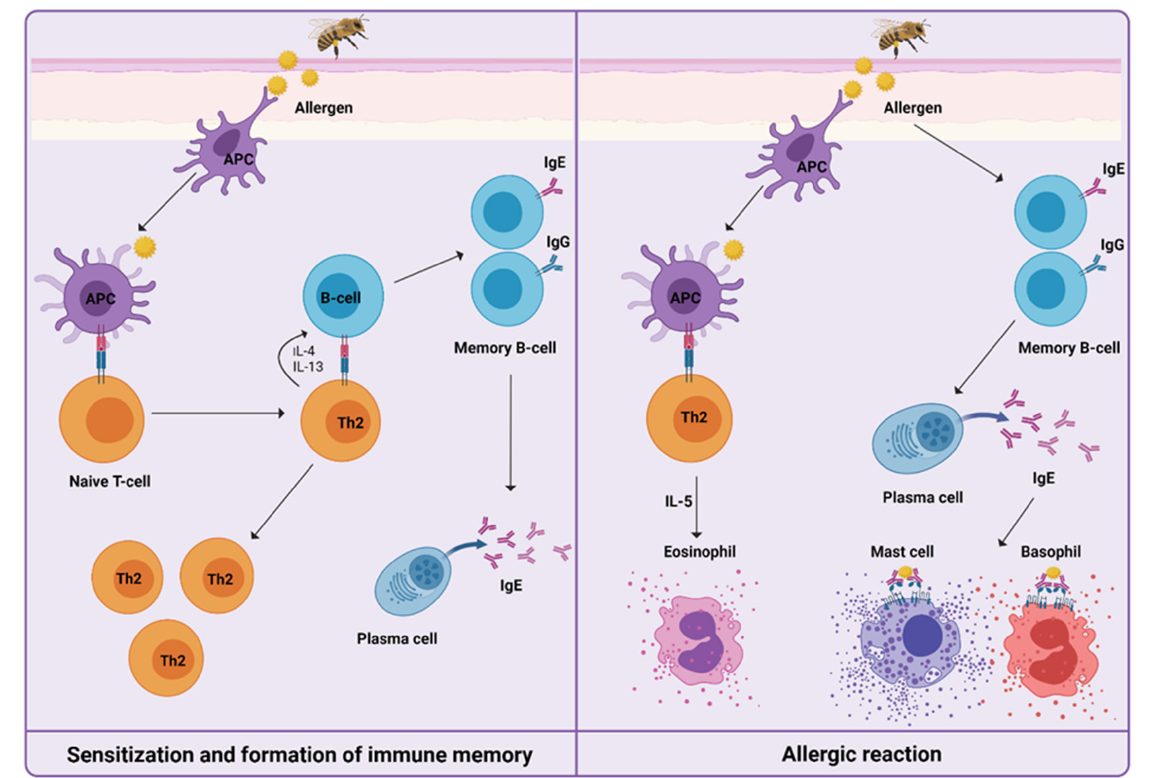
Figure 1. Mechanisms of a Hymenoptera venom allergic reaction can be divided into sensitization and formation of immune memory after the first exposure to venom, and the development of type I hypersensitivity reaction upon re-exposure to venom. Only cells and mediators previously described and further involved specifically in venom immunotherapy are shown.